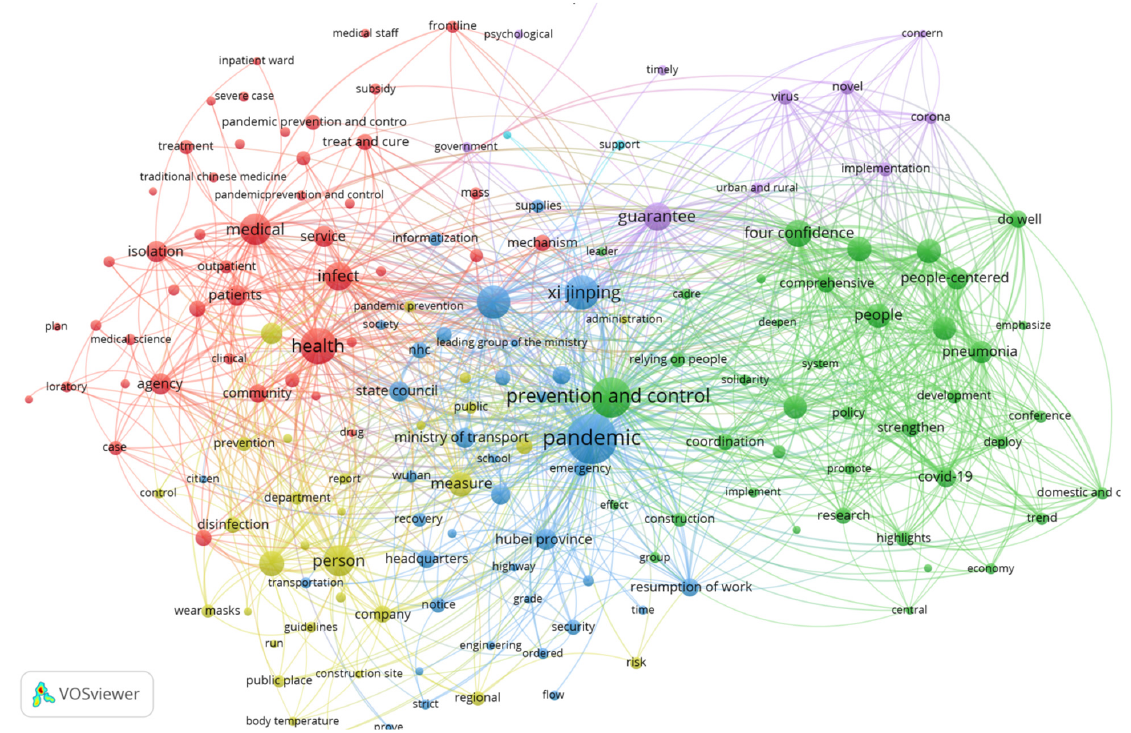
Figure 4. Network visualization of Chinese COVID-19 pandemic prevention and control policies. Source: Generated by the authors.